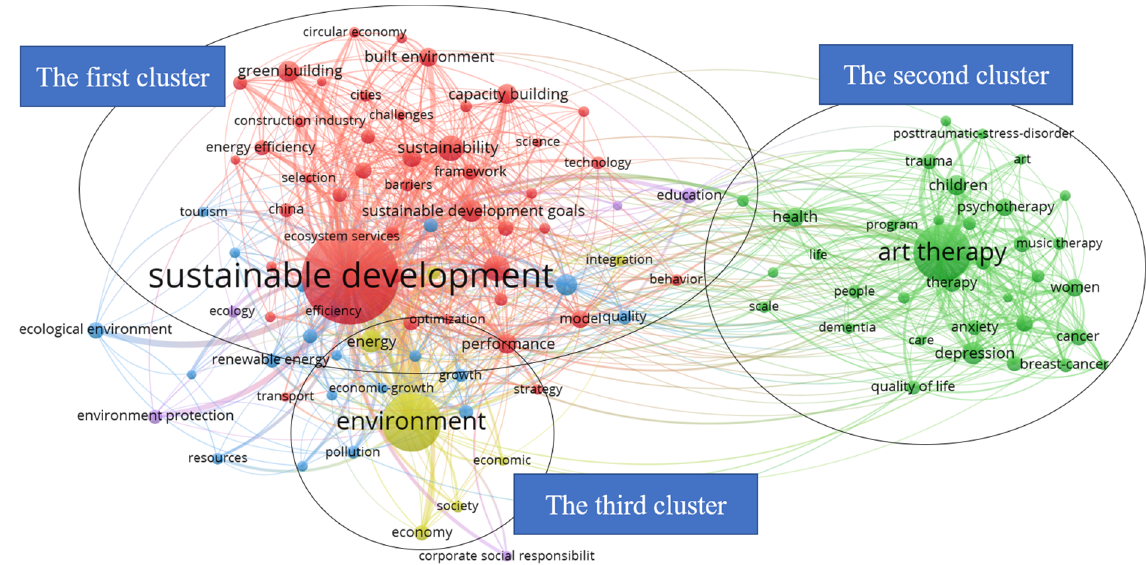
Figure 2. VOSviewer keyword network visualization map of building, environment, landscape design and art therapy in the context of sustainable development within the Web of Science (WoS) core collection database (devised by the authors).